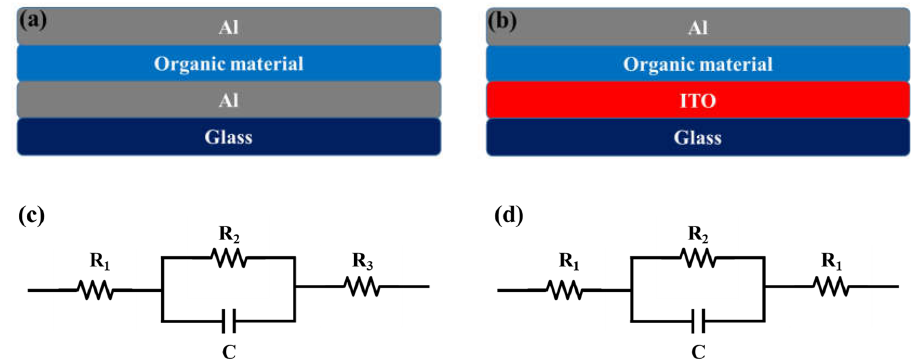
Figure 2. ( a , b ) show the studied device architectures for the dielectric strength measurements and ( c , d ) show their respective electrical circuit